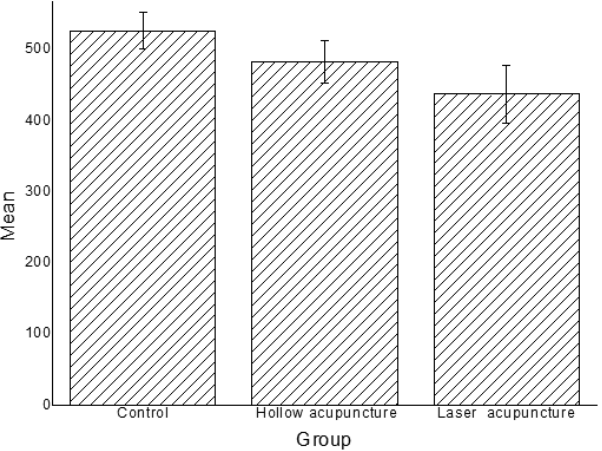
Fig. 6. ECG data analysis. The values presented are mean (cid:2) S.E.M. Data were analyzed using ANOVA and multi- ple comparison. There was no signi¯cant di®erence between Control group and Hollow group ( p ¼ 0 : 311 > 0 : 05), between Control group and Laser group ( p ¼ 0 : 093 > 0 : 05), and be- tween Hollow group and Laser group ( p ¼ 0 : 438 > 0 : 05).